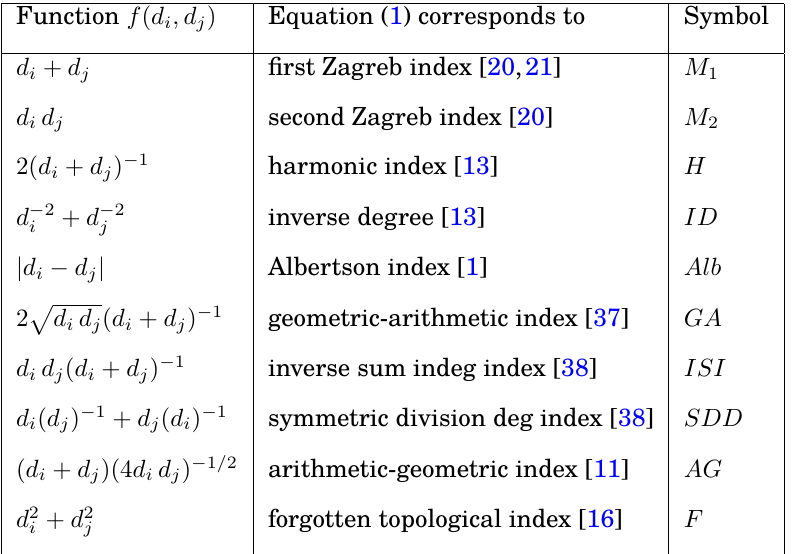
Table 1: The graph invariants to be used in the next